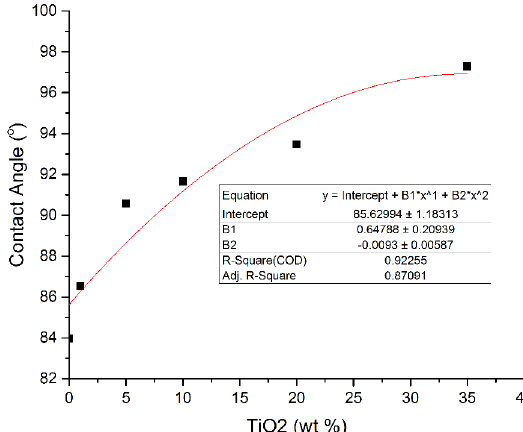
/ABS composites 2